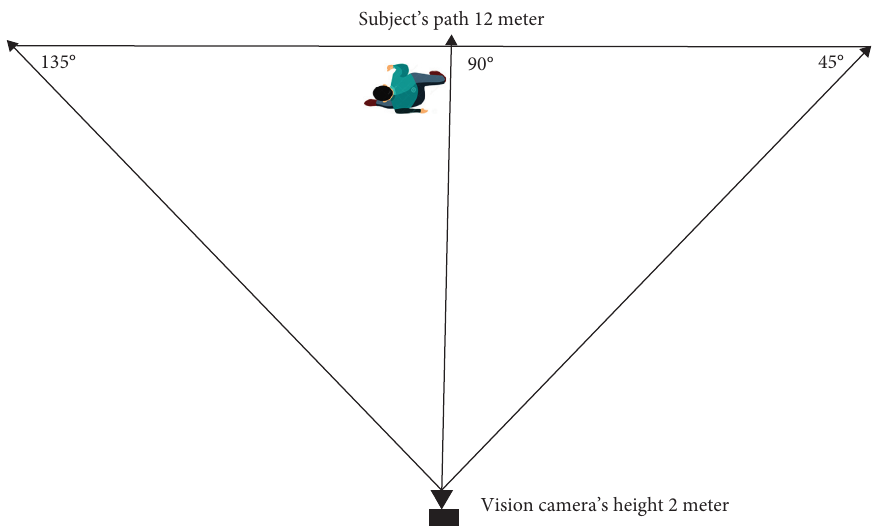
Figure 2: Indoor data collection setup for SACV-Gait dataset.